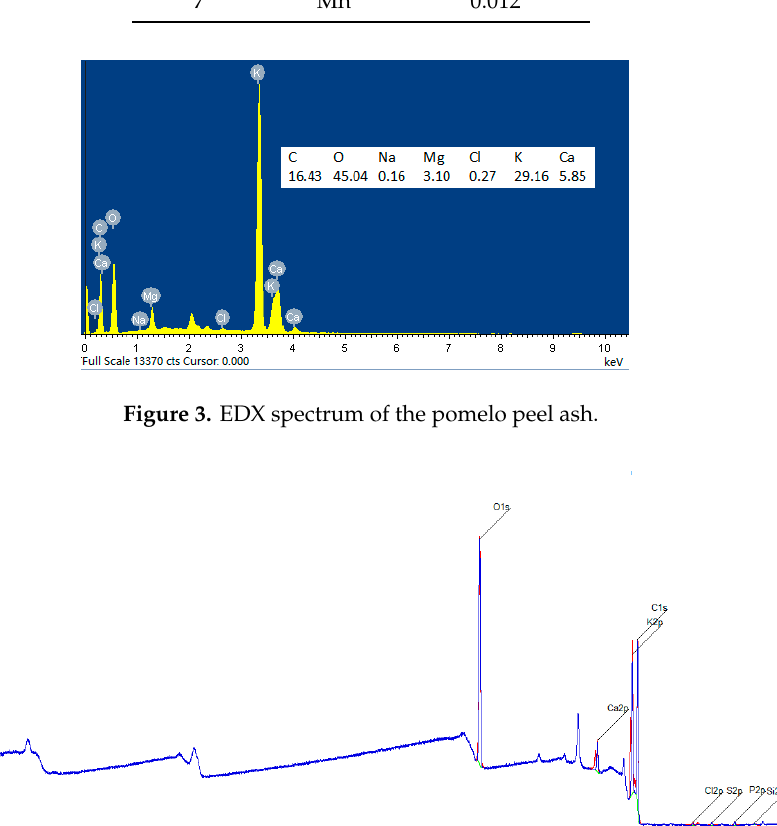
Figure 3. EDX spectrum of the pomelo peel ash.